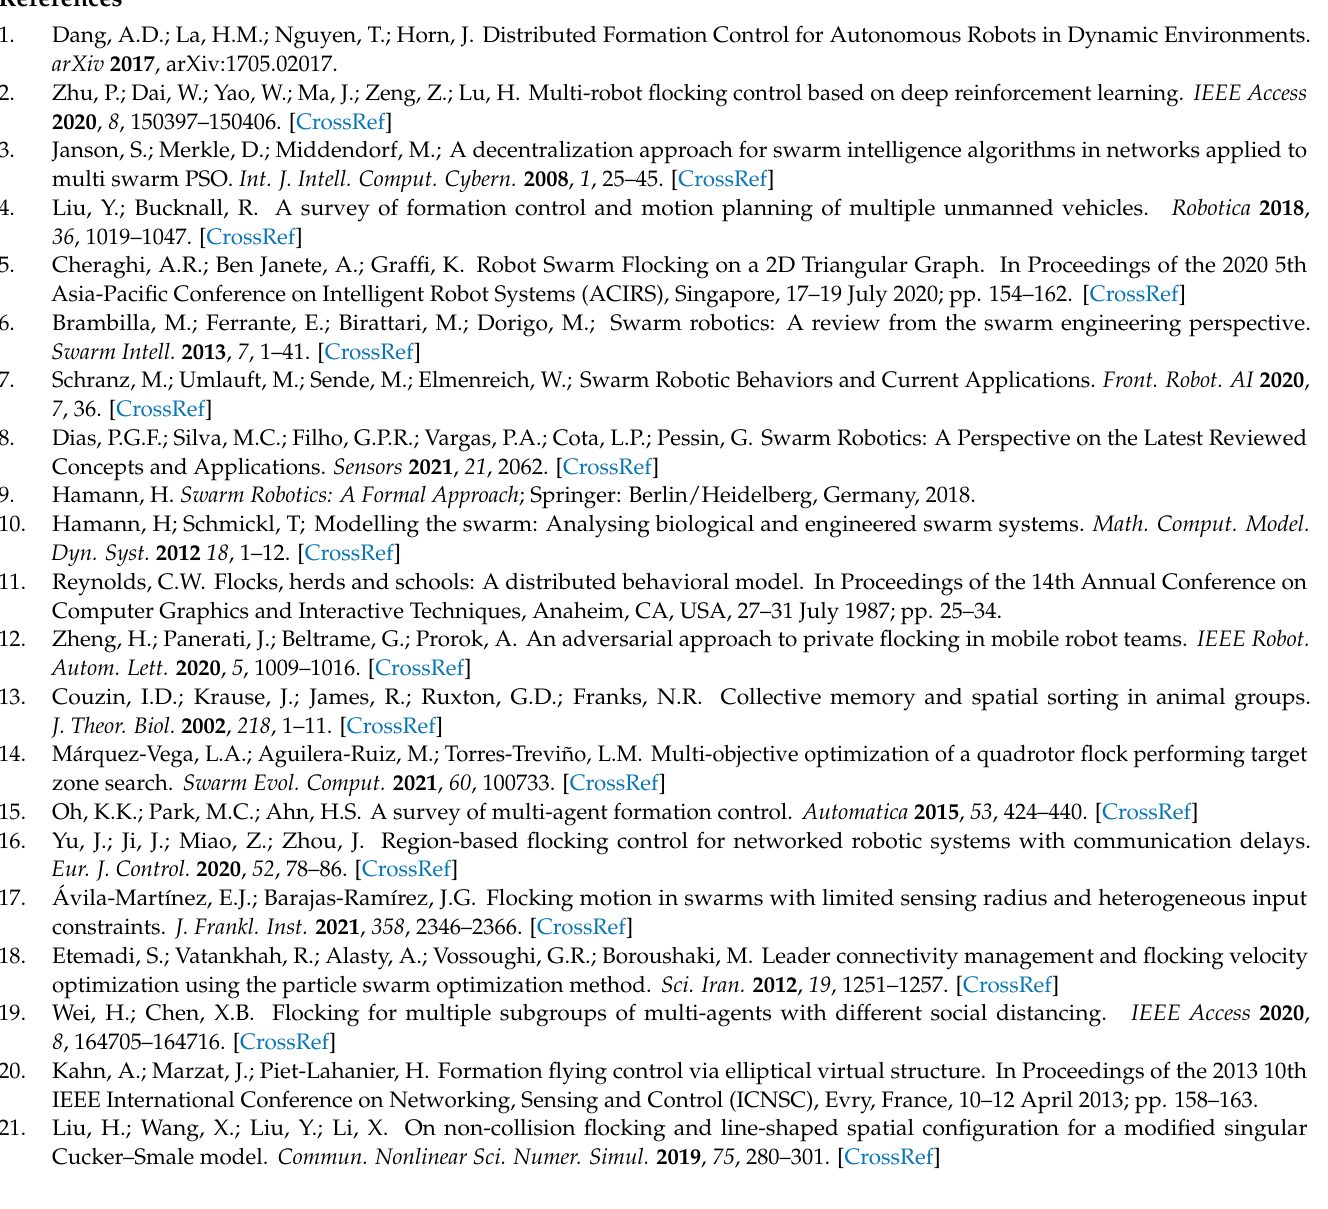
Figure A1. Snapshots of simulation experiments with flock sizes of 30 and 100, in an environment without